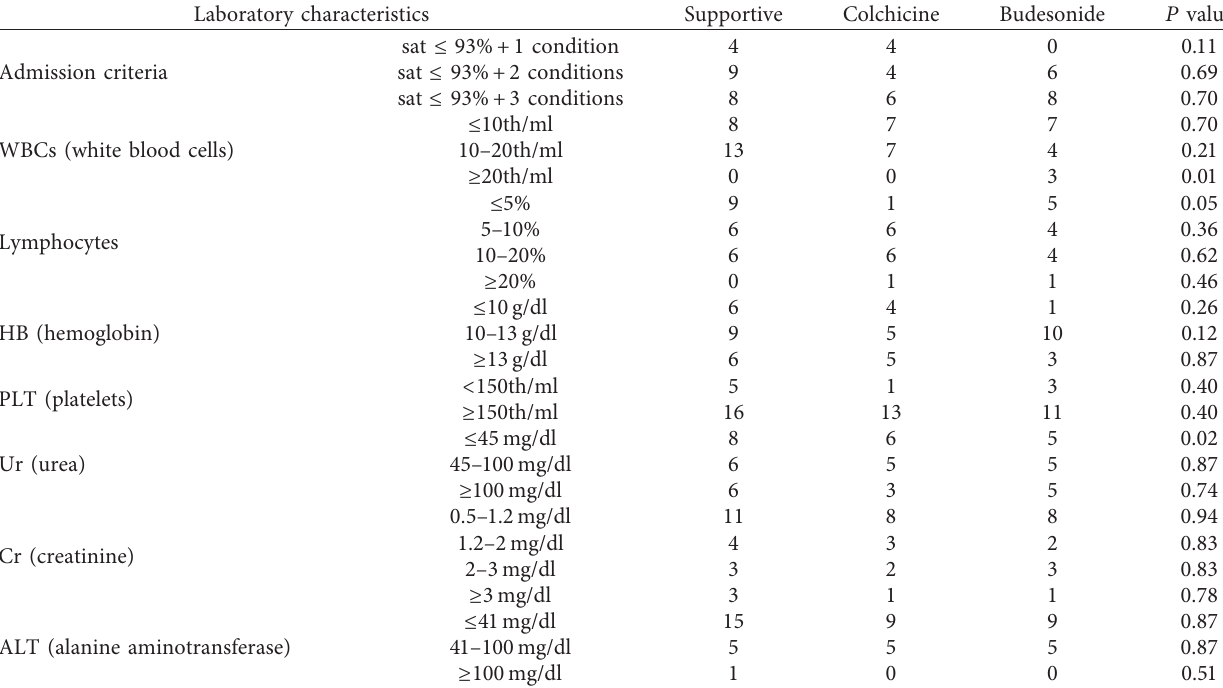
Table 2: Admission criteria, laboratories, and additional supportive